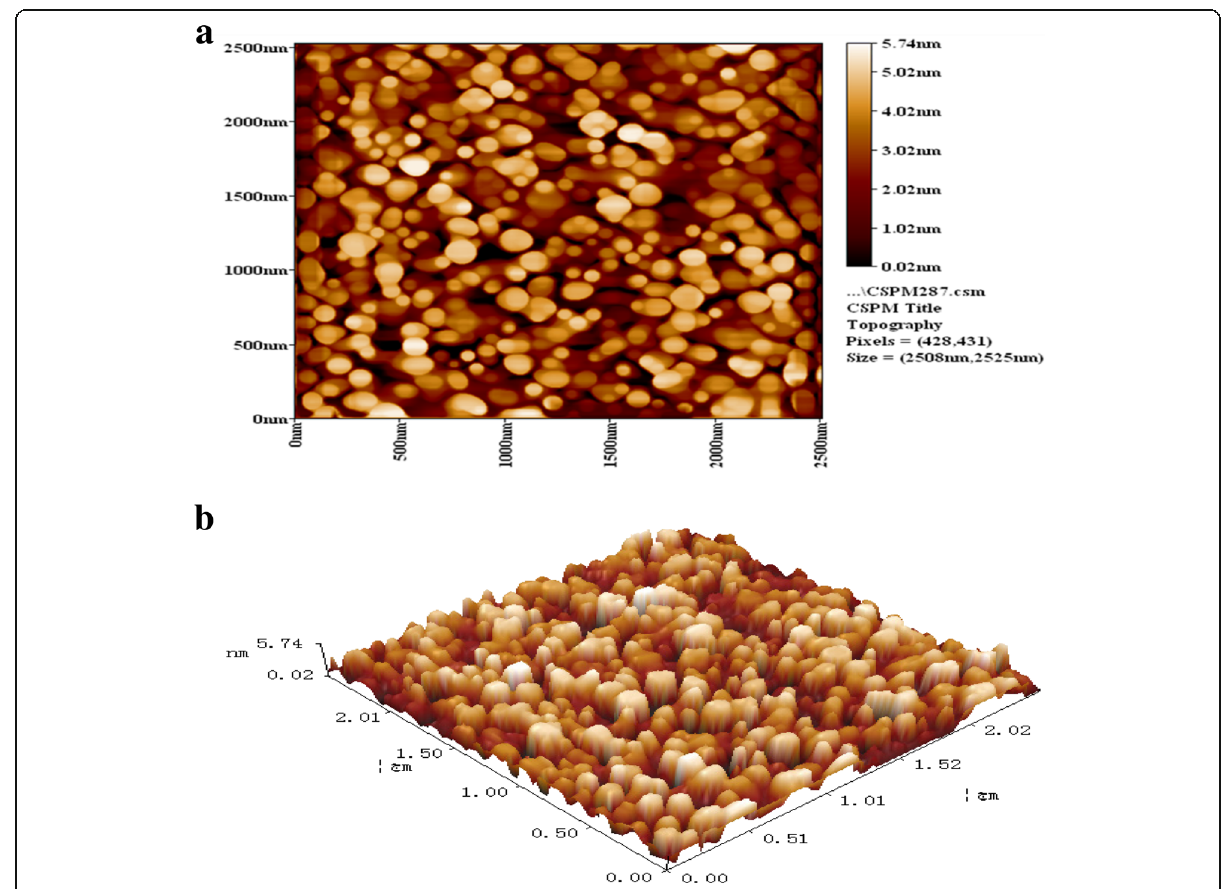
Fig. 11 Scanning probe microscopic image of optimum candesartan cilexetil nanoemulsion (NE-4) as: a Two dimensional topography (scope of image: 2508 nm 2525 nm), and b Three dimensional section of candesartan cilexetil nanodroplet